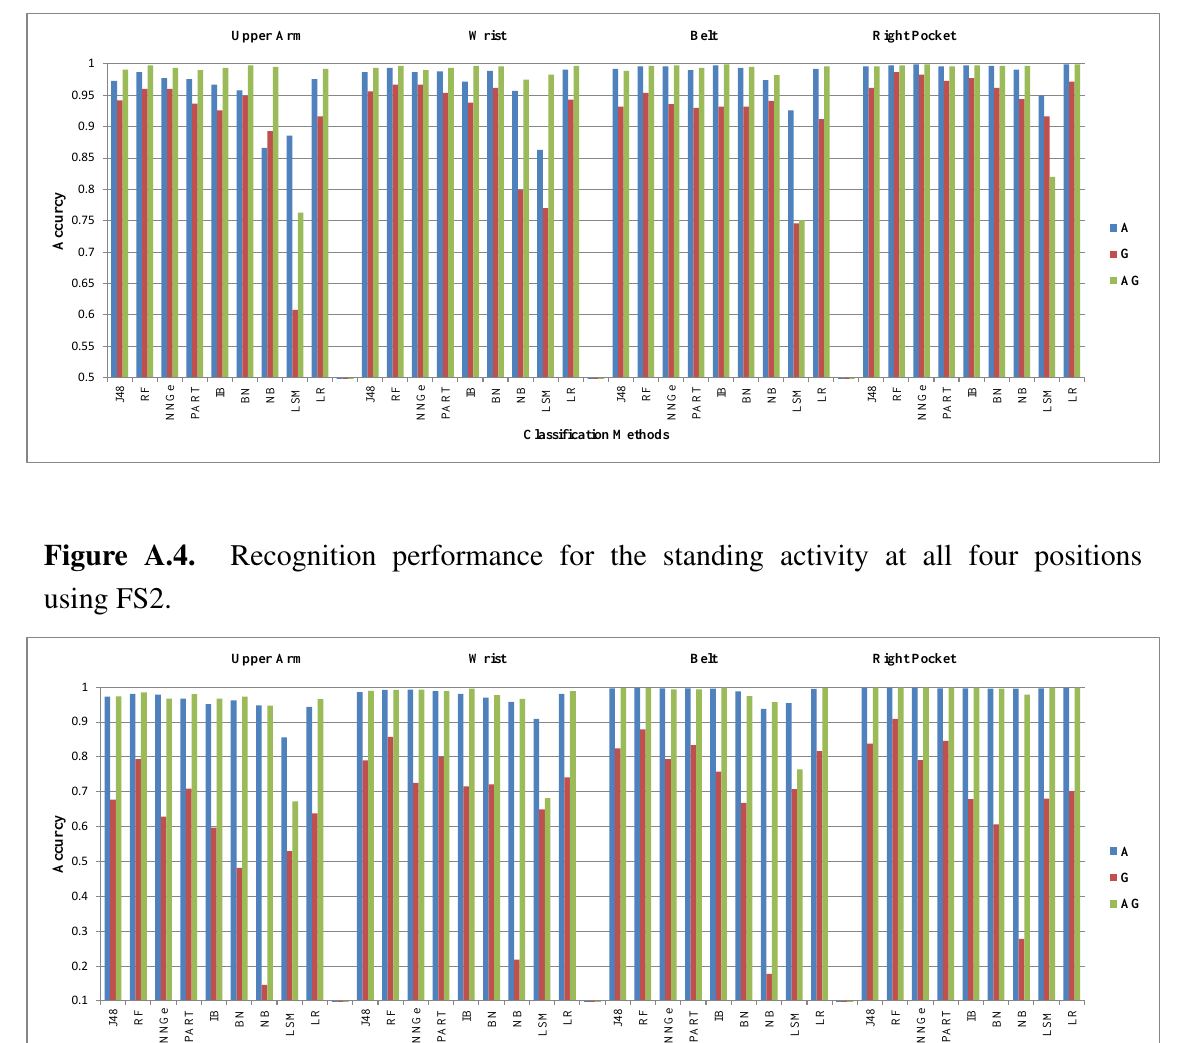
Figure A.3. Recognition performance for the biking activity at all four positions using FS2.